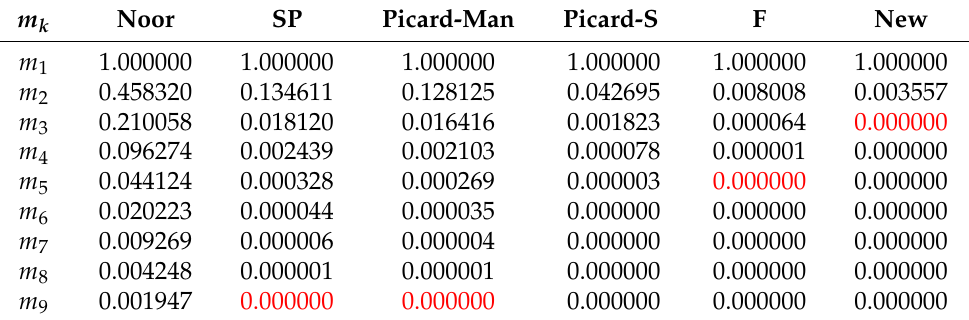
Table 2. Convergence behavior of various iterative algorithms.